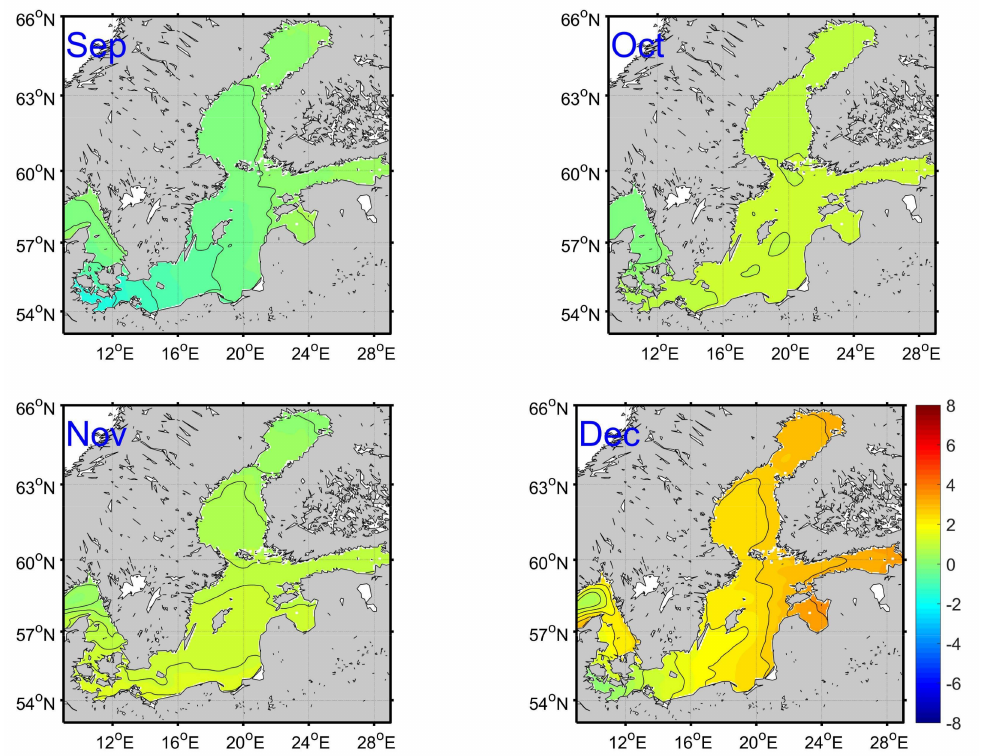
Figure 5. Similar to Figure 4 but for SMHI reanalysis of CSEOF first mode monthly time-dependent LVs